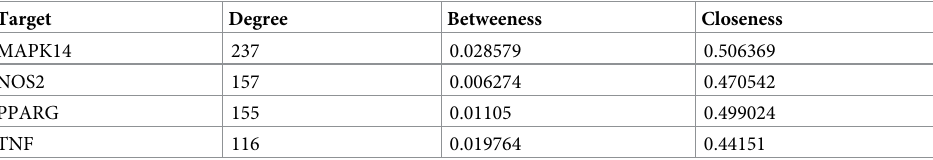
As shown in Fig 3, the biological processes by the MAPK signal pathway were often associ- ated with the higher target hit quantity. Especially, the MAPK signal pathway had been indi- cated to contribute to liver metabolic changes, liver steatosis, and hepatic cell apoptosis during the progression of gluconeogenesis and lipid metabolism. As the major p38 MAPK isoform, p38 α ubiquitously expressed at high levels in most cell types and played a pivotal role in elevat- ing liver enzymes, survival genes, DNA damage, oxidative stress, inflammation response due Table 2. The detail about core target in the component-target interaction network. Degree